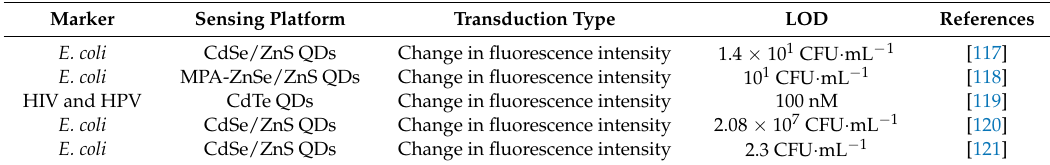
Table 11. QDs-based sensors for bacteria and viruses